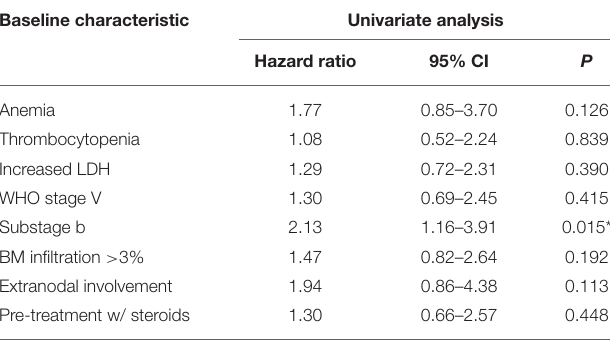
Table 2 . According to the logistic conditional